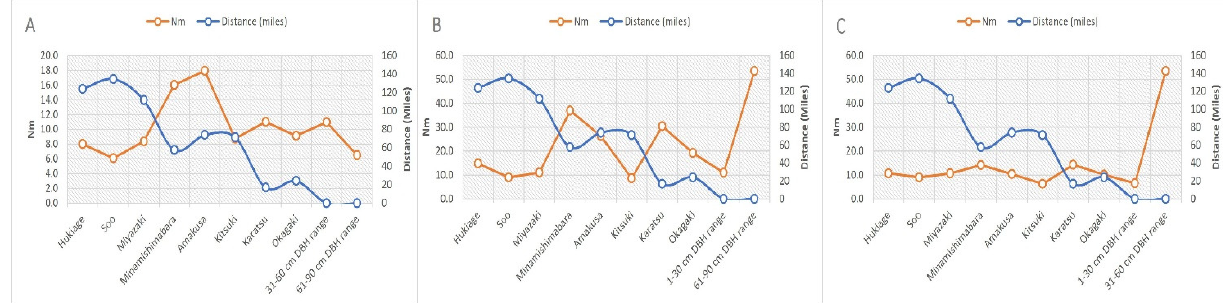
Figure 3. Relationship between gene flow ( Nm ) and distance with other populations in the Kyushu area on the following basis: ( A ) 1–30 cm DBH class range; ( B ) 31–60 cm DBH class range; ( C ) 61–90 cm DBH class range.